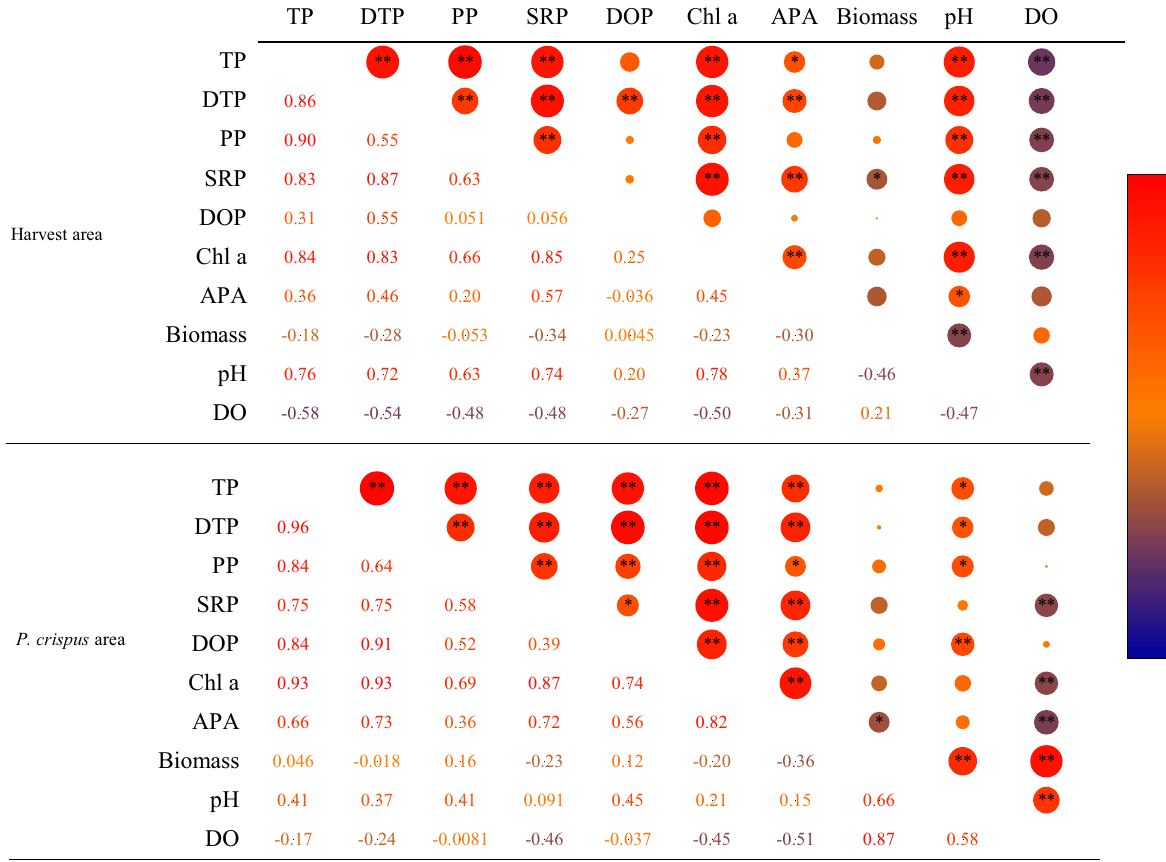
Table 3. Pearson’s correlation coefficients describing the relationships between water chemical and physical parameters in the two studied